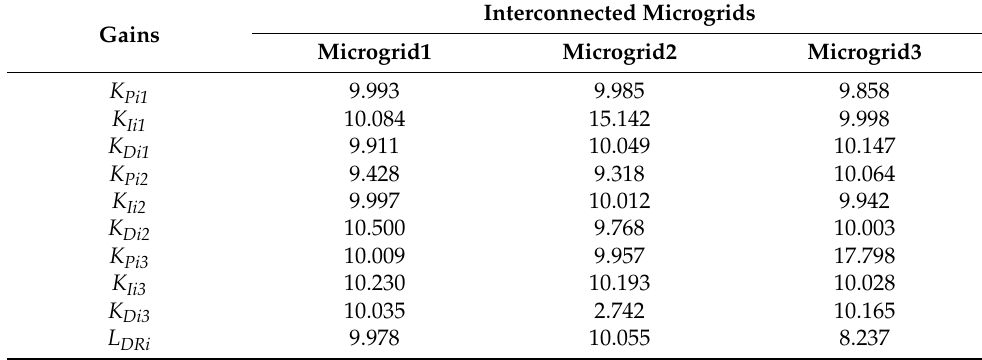
Table 5. Optimized controller gains using QCSHO and